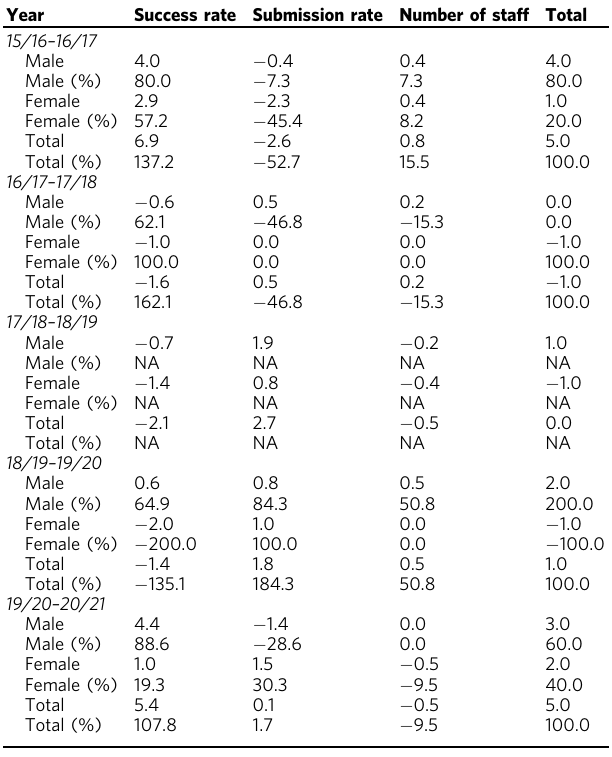
Table 2 Decomposition analysis for annual changes in the number of